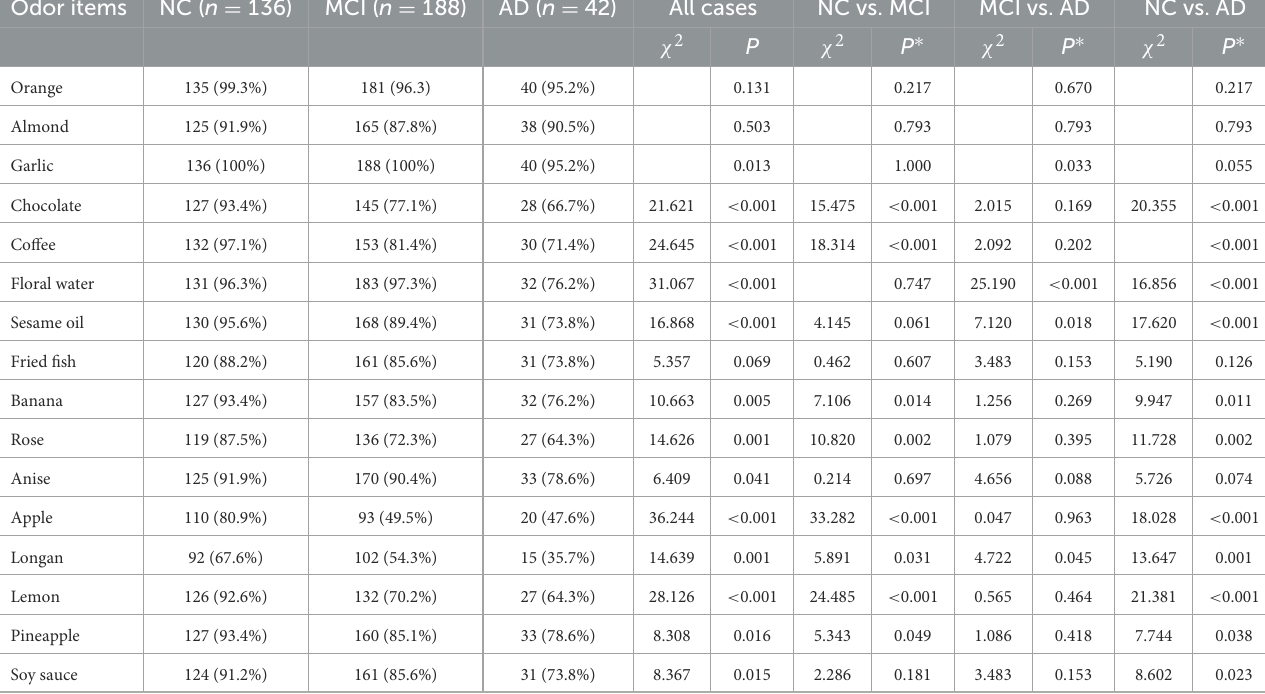
TABLE 2 Comparisons of accuracy in odor identification in each item of CSIT in the three